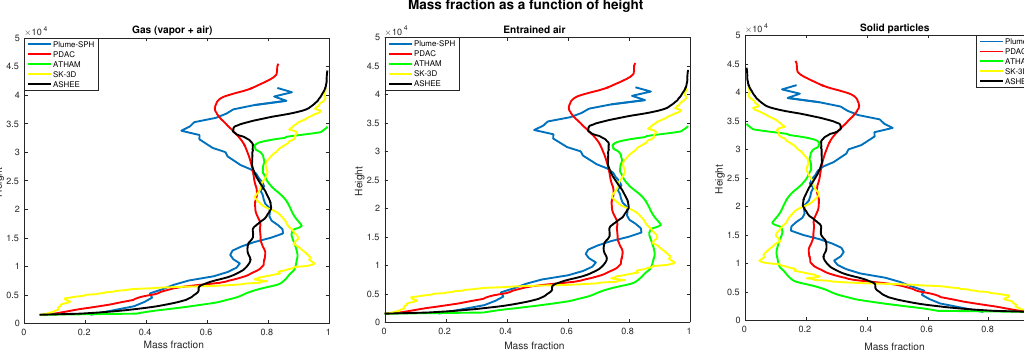
Figure 12. The mass fraction of entrained air, gas and solids as a function of height.